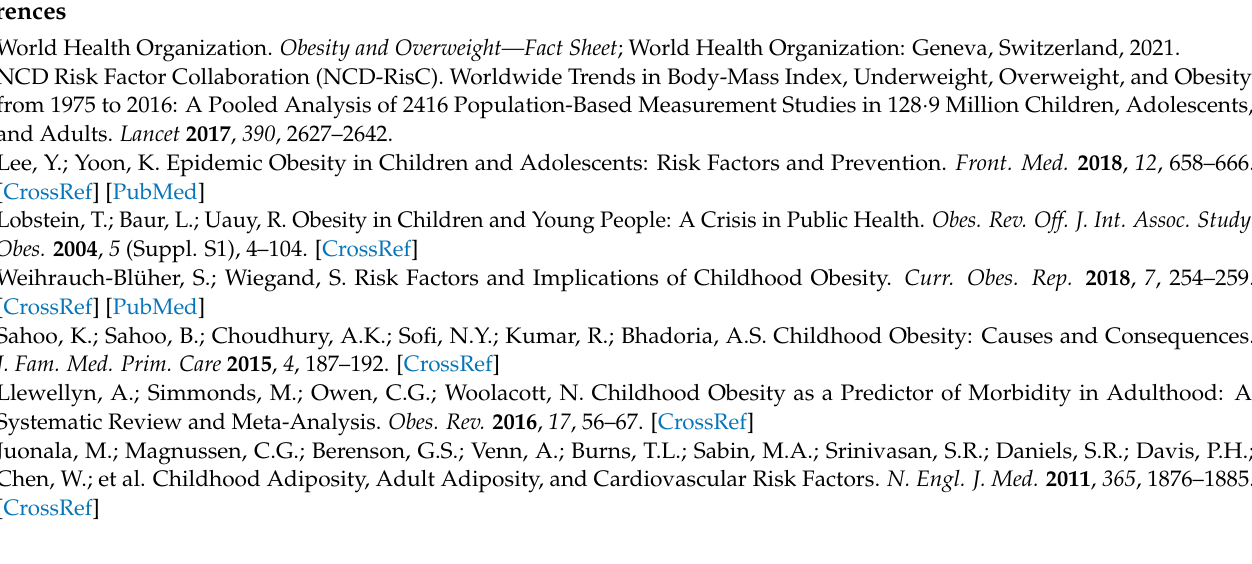
Table S5. Out- comes for behavior change interventions, Table S6. Outcomes in multi-component